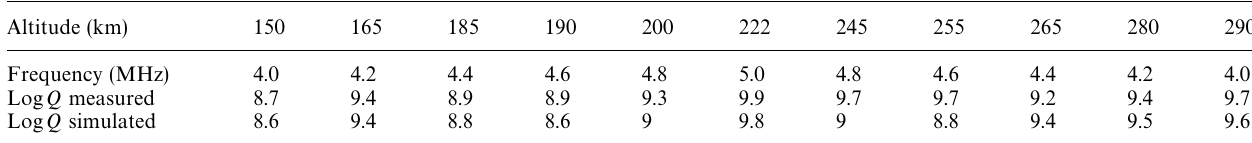
of the F region. Row 3 shows the plasma line signal strength as log Q , where Q is defined in the paper of Fredriksen et al . (1989), whereas row 4 shows the log Q values obtained from a simulation using the model fluxes presented in this study